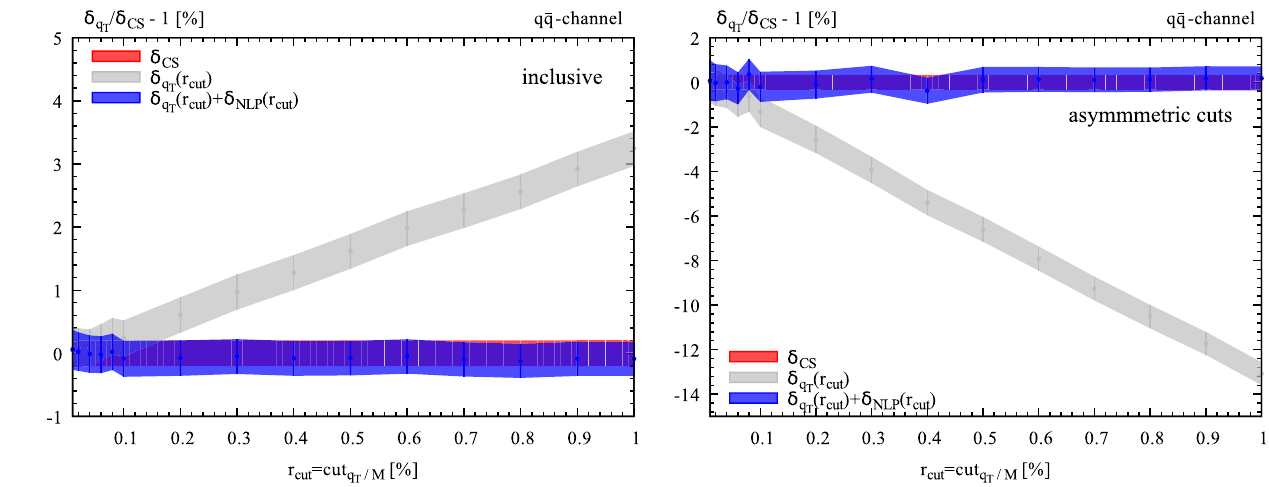
the result obtained by including the power suppressed contribution in Eq. (48). The NLO result is normalised to the r cut -independent cross section computed with dipole